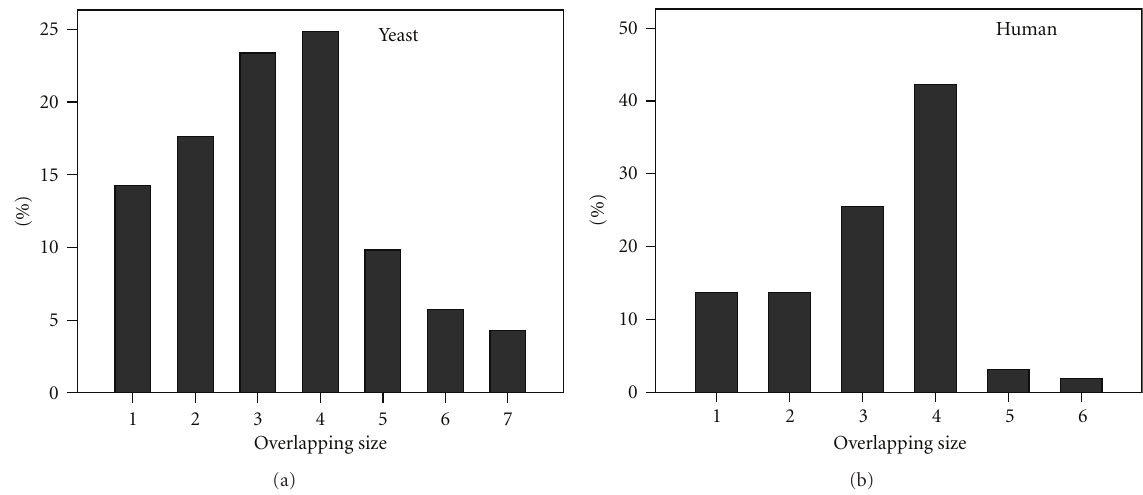
Figure 6: Overlapping size distribution of yeast and human PPI network after removing repeats. The x -axis represents the overlapping size. The y -axis is the percentage of each size. (a) Yeast PPI network. (b) Human PPI